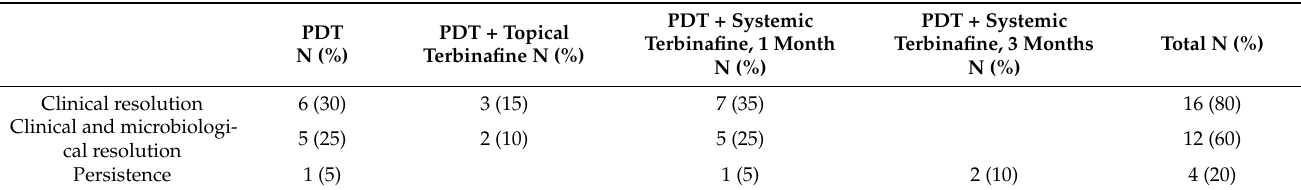
Table 2. Cure rates.